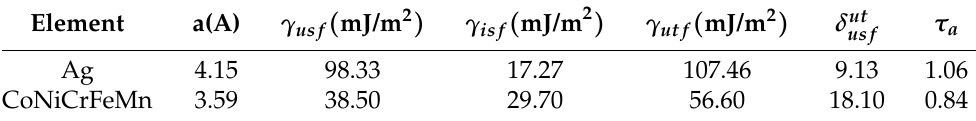
Table 2. Stacking fault energy values obtained from the density functional theory simulations as implemented in VASP [53]. SFE values for CoNiCrFeMn are taken from the reference [52].